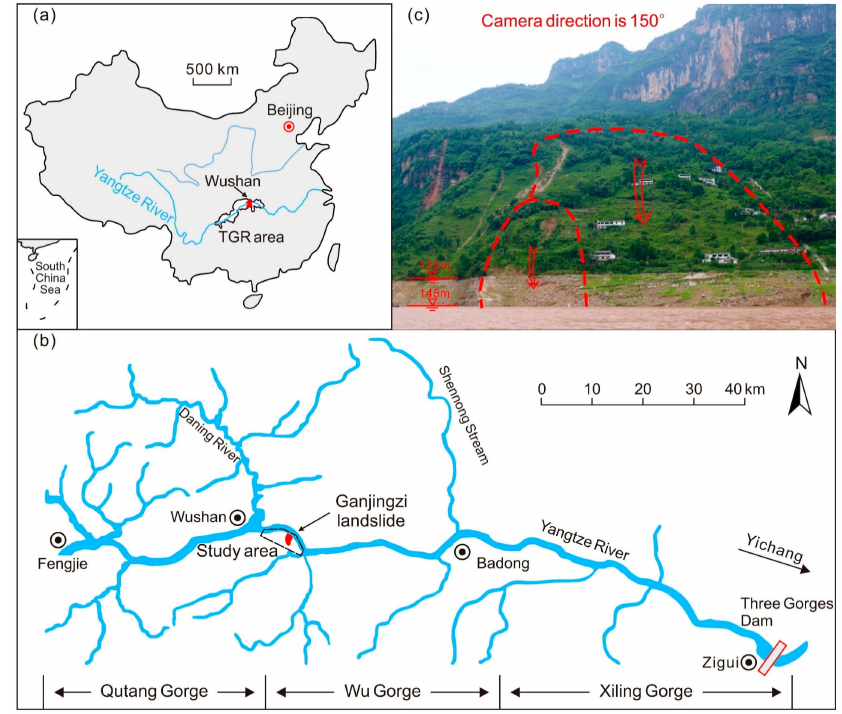
Figure 1. Location of the study area: ( a ) site location of the study area in China, ( b ) location of the Ganjingzi landslide, and ( c ) geomorphological characteristics of the Ganjingzi landslide.